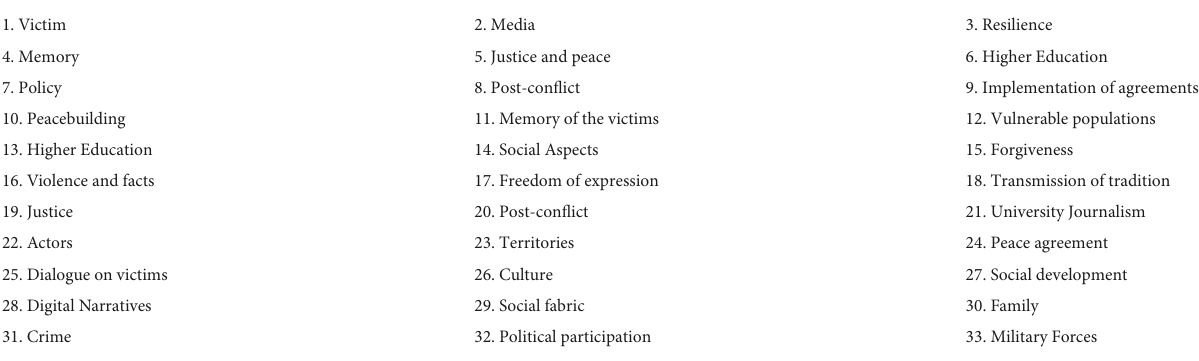
TABLE 1 Classification process of the RUTAS information. Intermediate categories (from a first analysis of lexical